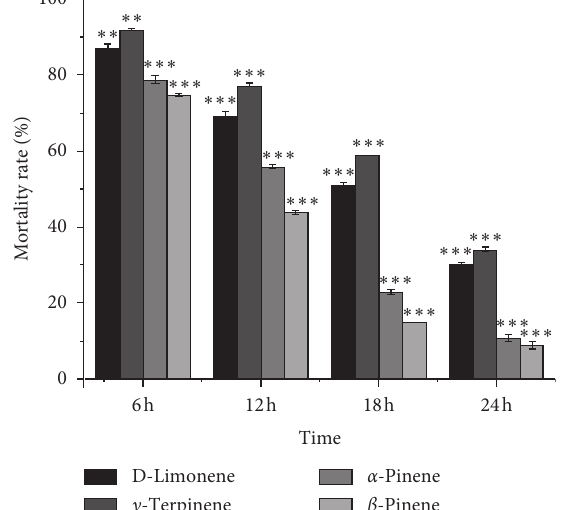
Figure 5: Four compounds in the flesh fingered citrons essential oil affect the survival rate on C. elegans . Results include at least three independent biological replicates. Error bars represent the standard error, and differences compared to the control (for each column of 0mg/ml, 0.1% were considered significant at ∗ P < 0 . 05 , ∗∗ P < 0 . 01 , and ∗∗∗ P < 0 . 001 by one-way ANOVA and the LSD post hoc test.